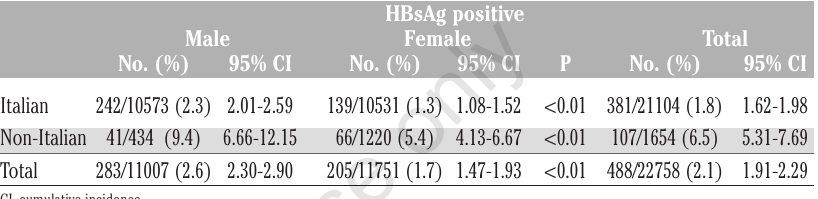
Table 1. Hepatitis B surface antigen (HBsAg) seropositivity by gender in Italian and non- Italian patients (2007-2008).